Question: In a single sentence, describe what this figure presents.
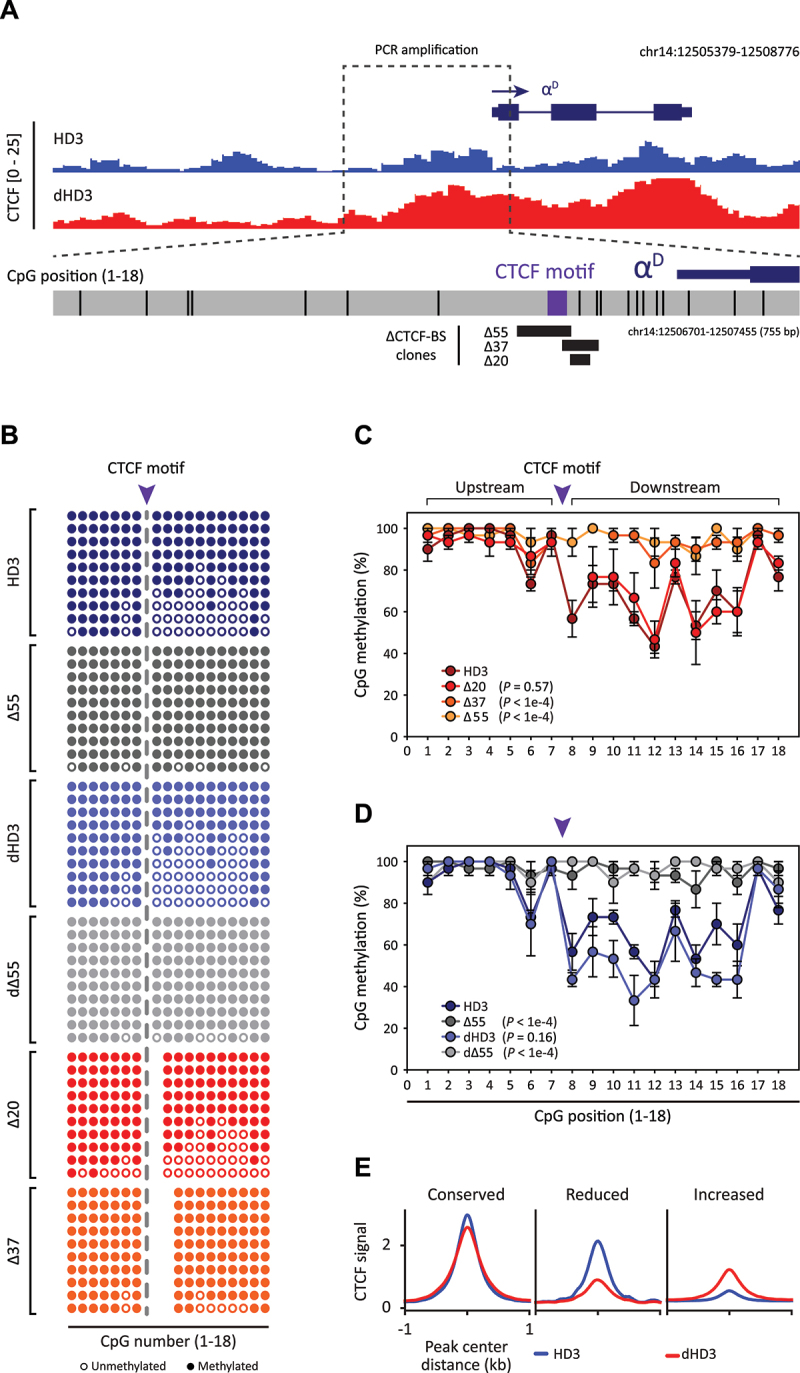
Answer: The CTCF-BS prevents DNA methylation from spreading towards the α D gene in erythroid cells. (A) Genomic view of the PCR-amplified region used for bisulfite conversion analysis at the CTCF-BS region. CpG positions (1–18) relative to the CTCF motif are shown as vertical lines. (B) The methylation status of individual CpG sites is displayed as filled circles (methylated) and open circles (unmethylated) in each condition. Missing circles represent deleted CpGs in the mutant clones. (C and D) Mean methylation percentages for each CpG in mutant and HD3 cells. Data represent the mean ± SEM from three independent bisulfite conversion experiments (8–10 sequenced clones per experiment). Significance was determined by a two-tailed unpaired Student t -test. (E) Profile plots showing the CTCF-binding signals at differentially CTCF-bound sites in HD3 and dHD3 conditions.